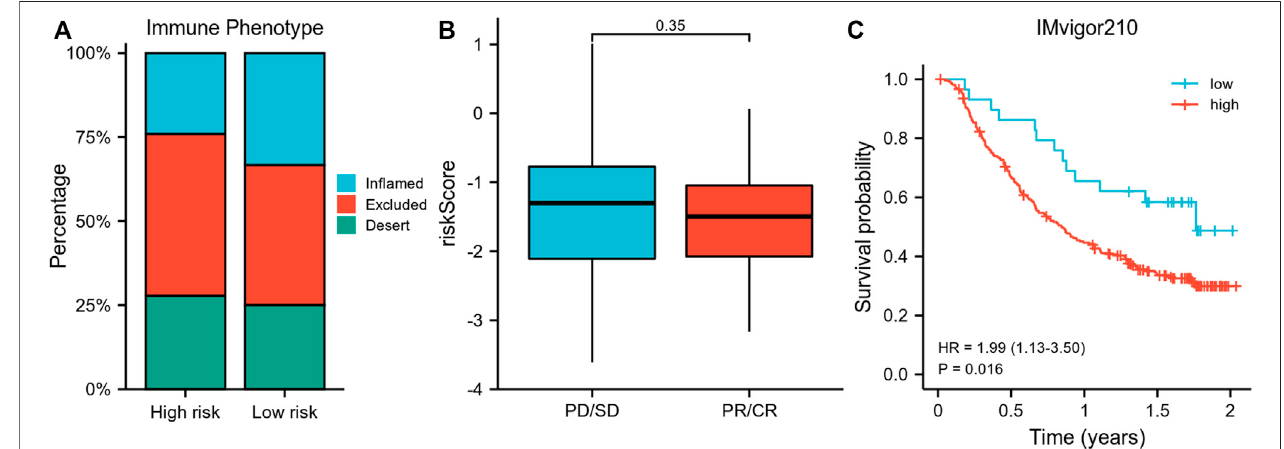
FIGURE 6 | Validation of the risk model using IMvigor210 data. (A) Comparison of the proportion of immune phenotypes between high-risk and low-risk groups. (B) The association of the risk score and immune response after immunotherapy. (C) Survival curve of risk groups receiving immunotherapy. PR, partial response; CR, complete response; PD, progressive disease; SD, stable